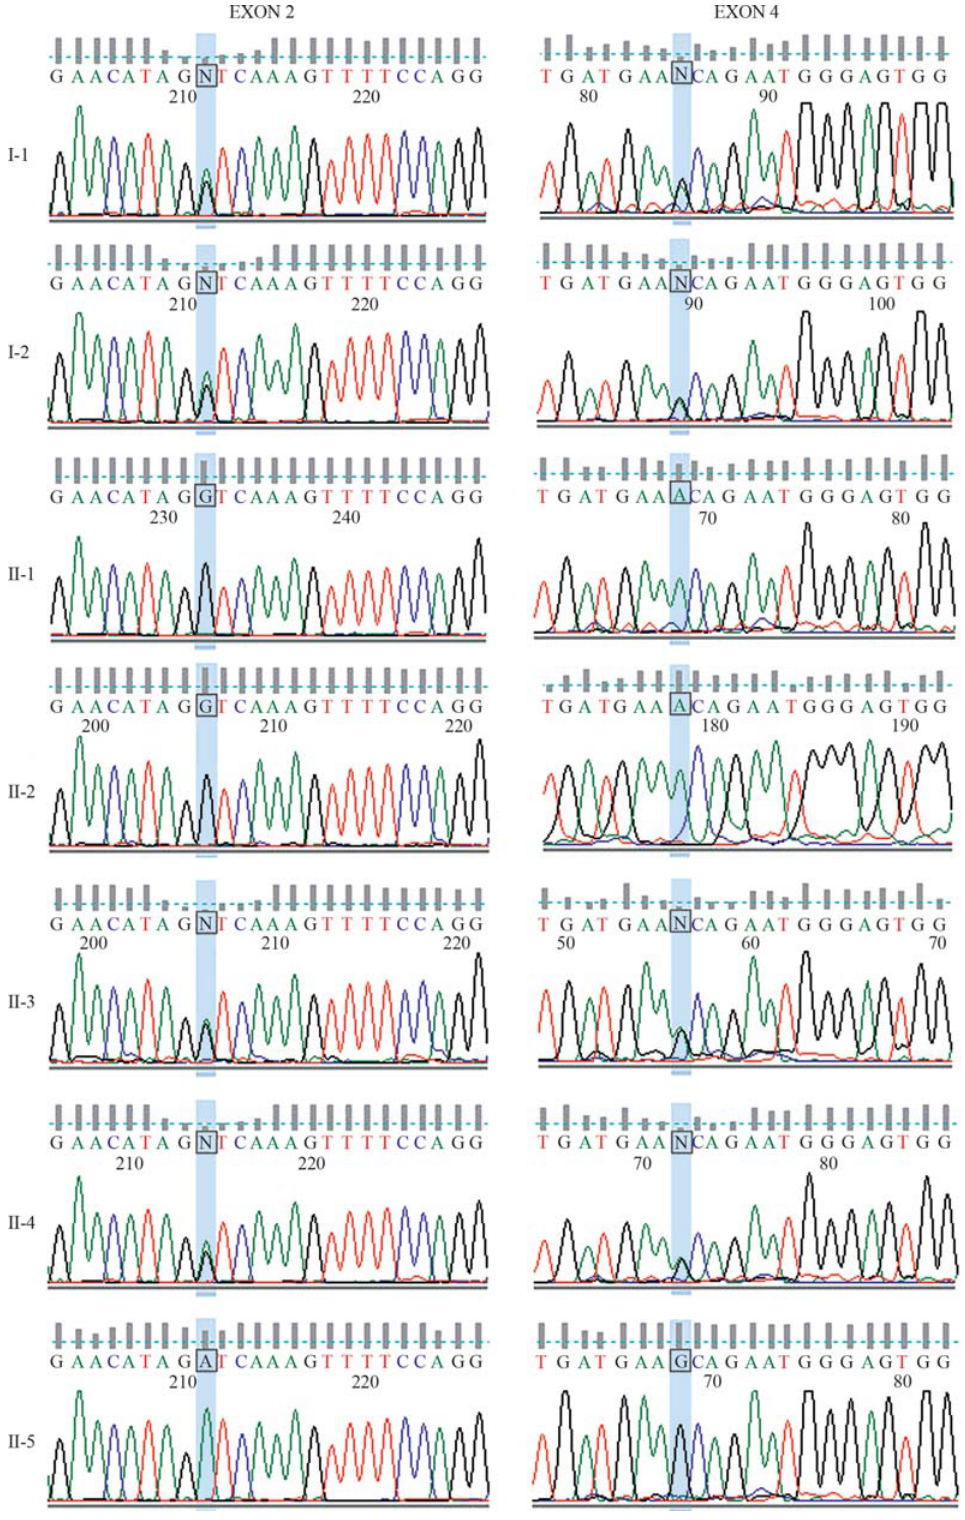
Figure 2 - Description of the mutations in the BCHE gene of the patient and her relatives. The figure shows the sequencing electropherograms of the am- plified fragment of exons 2 and 4 of the analyzed individuals. The highlighted bases (blue) indicate the position of the mutations. The left column shows the results of the analysis of exon 2. Missense mutation GAT to GGT in codon 70 was found in heterozygosis in subjects I-1, I-2, II-3 and II-4, and in homozygosis in subjects II-1 and II-2 (patient). The right column shows the results of the analysis of exon 4. Missense mutation GCA to ACA in codon 539 was found in heterozygosis in individuals I-1, I-2, II-3 and II-4, and in homozygosis in individuals II-1 and II-2 (patient). Subject II-5 did not present mutations in any of both exons. Individuals are identified as in Figure